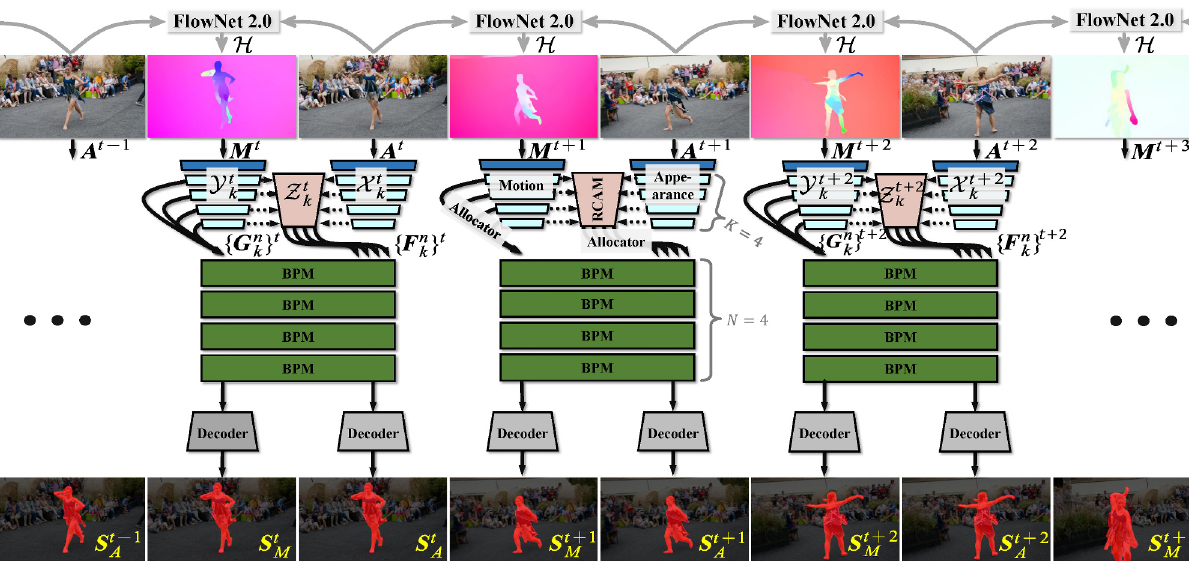
Fig. 3 Architecture of our FSNet for video object segmentation. The relational cross-attention module (RCAM) abstracts more discriminative representations linking motion and appearance cues using the full-duplex strategy. Then four bidirectional purification modules (BPM) are stacked to further resolve inconsistencies between the motion and appearance features. Finally, we utilize a decoder to generate our prediction.